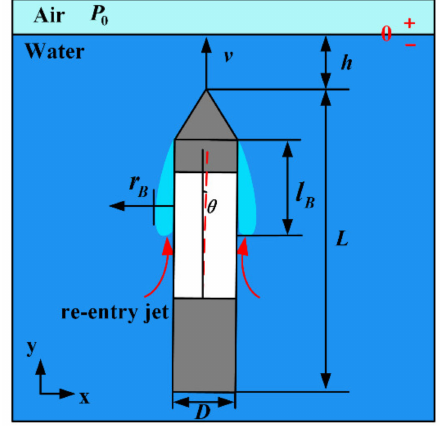
Figure 3. Schematic diagram of